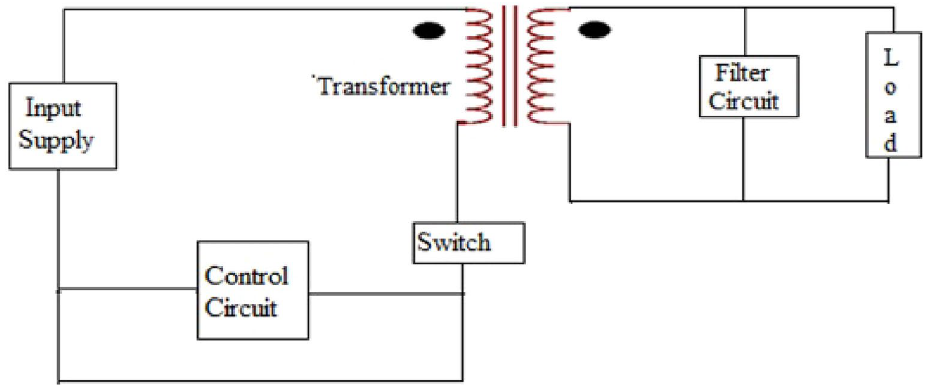
Figure 3. Schematic diagram of a current forward converter.